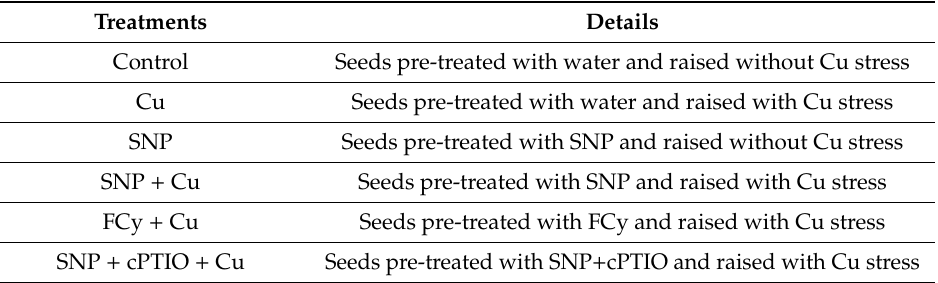
Table 1. Experimental